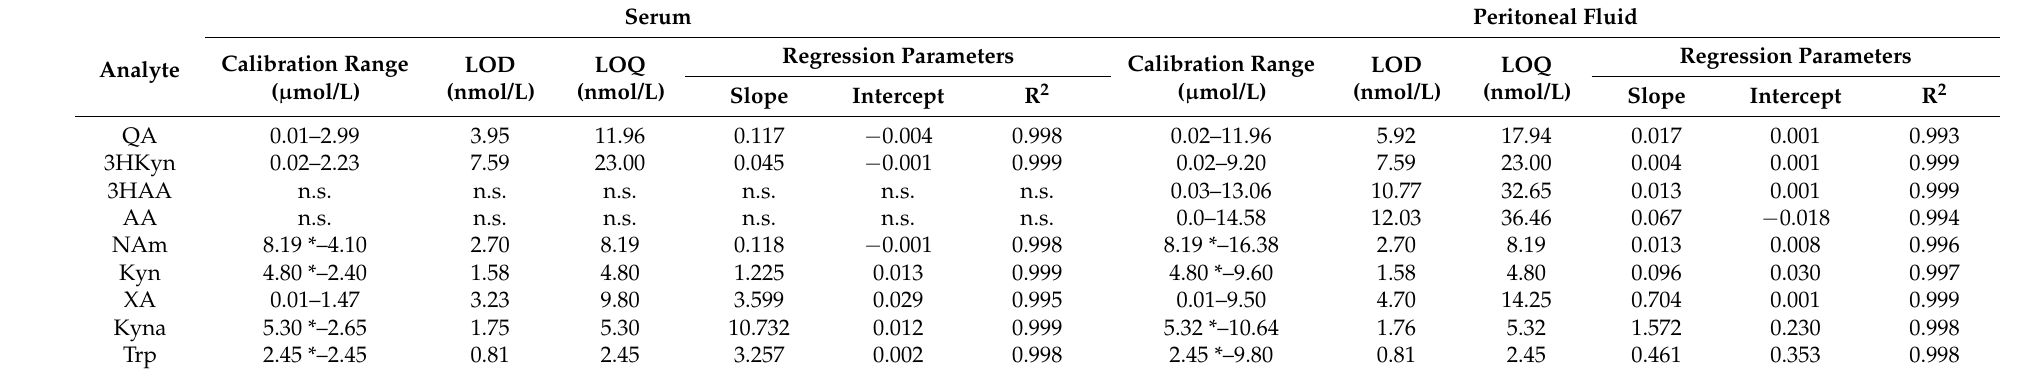
Table 2. Linearity and parameters of the calibration curves.